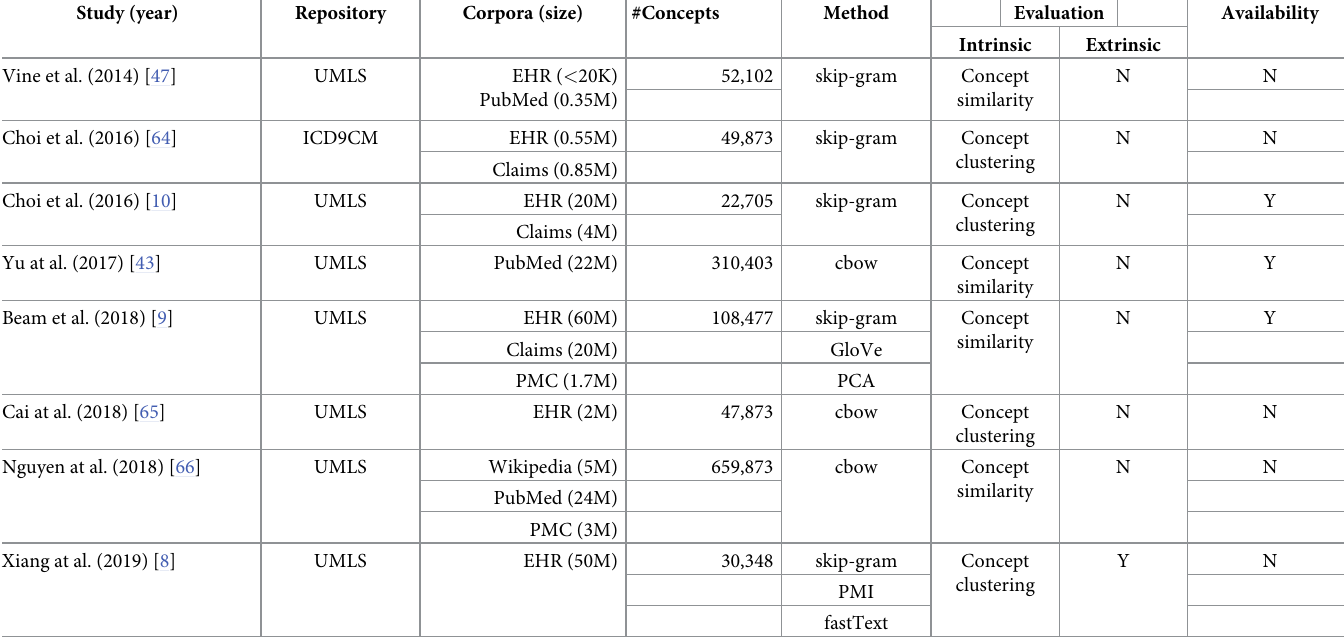
Table 1. An overview of biomedical concept embeddings trained on large-scale free-text corpora. Repository: the scope of concepts. Corpora: the training collection. Note that for EHR (electronic health records) and Claims (medical claims), the size is the number of patients, whereas for Wikipedia, PubMed (abstracts), and PMC (full- text articles), the size is the number of documents. #Concepts: the number of distinct concepts in the embedding. Method: the method for training embeddings. PCA: prin- ciple component analysis. PMI: pointwise mutual information. Intrinsic evaluation: a focus on applications that directly use the similarity between the vectors produced by word embeddings, such as word-pair similarity and relatedness. Extrinsic evaluation: a focus on downstream applications that use only word embeddings as an intermedi- ate component. For example, the last study evaluated the effectiveness of concept embeddings for heart-failure prediction. Availability: whether the studies made the embeddings publicly available (we accessed on